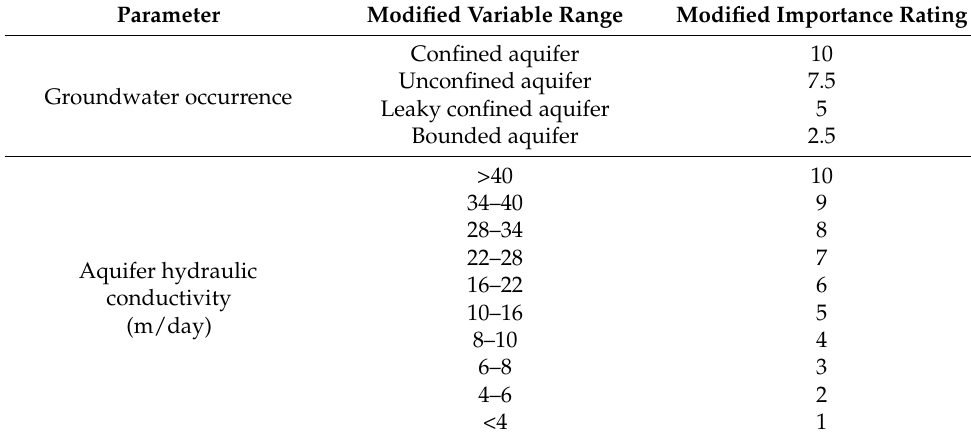
Table 2. Modified rates for